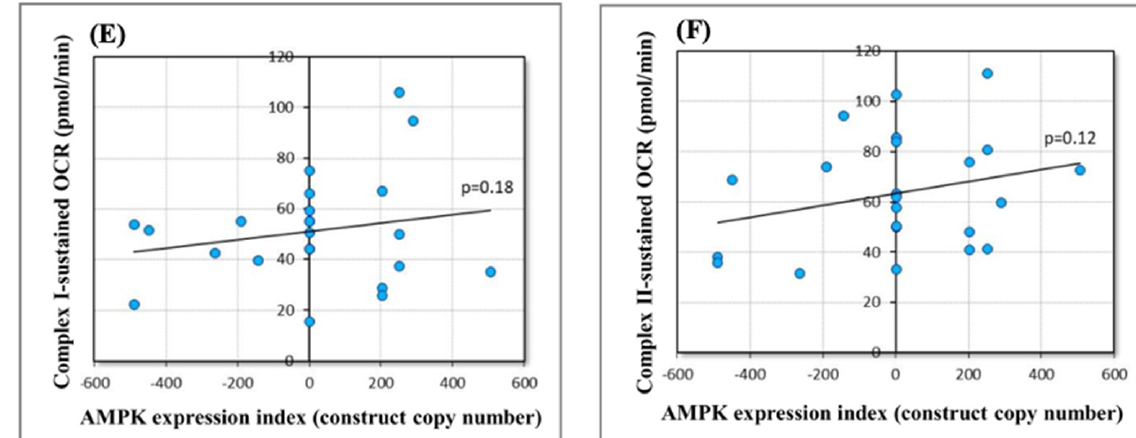
Figure 5. Effect of AMPK expression levels on mitochondrial respiratory function. Respiratory O 2 consumption rates (pmol/min) were assayed using 1 × 10 5 amoebae per well of the wild-type parental strain (A × 2) or strains stably transformed with either an AMPK antisense-inhibition or overexpression construct. A predetermined convention was followed using the copy number of the construct as an expression index (negative numbers for antisense inhibition and positive numbers for overexpression). To estimate the contribution of the ATP-linked oxygen consumption rate (OCR) ( C ) and non-ATP-linked OCR (proton leak) ( D ) to the basal respiratory rate ( A ), N,N (cid:48) -dicyclohexylcarbodimide (DCCD) was added to inhibit ATP synthesis at Complex V. Subsequently, a protonophore (uncoupler) carbonyl cyanide 3-chlorophenol hydrazone (CCCP) was added to determine the maximum OCR ( B ). The subsequent addition of rotenone (Complex I inhibitor) and either antimycin A (Complex III inhibitor) or benzohydroxamic acid (BHAM, AOX inhibitor) allowed to estimate the contribution of Complex I ( E ) and Complex II (Complex II/III + Complex II/AOX) ( F ) to the maximum OCR. The slope of the regression line was positive as assumed in all cases, reaching statistical significance in the case of the basal OCR and the maximum uncoupled OCR.